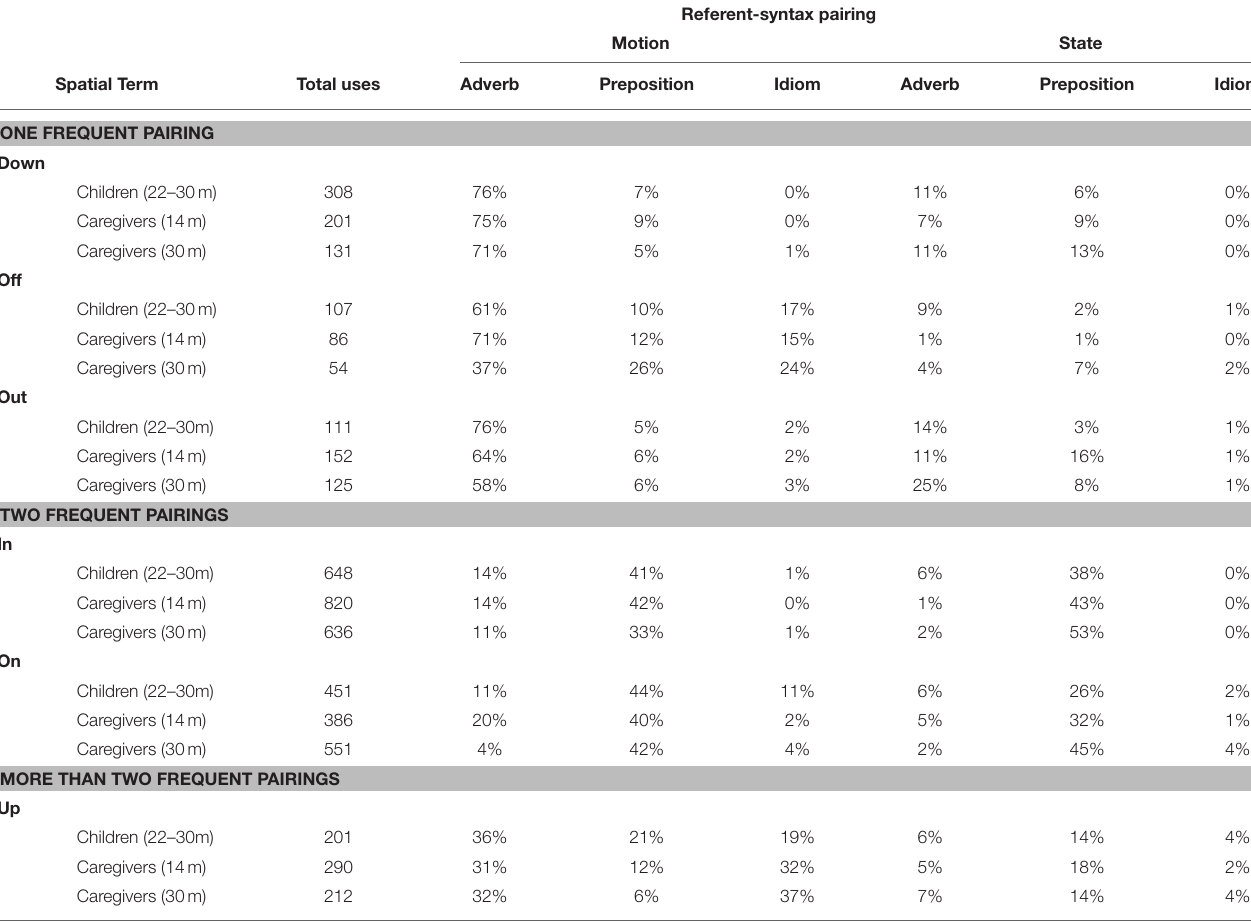
TABLE 3 | Caregiver and child spatial terms by referent-syntax pairing.